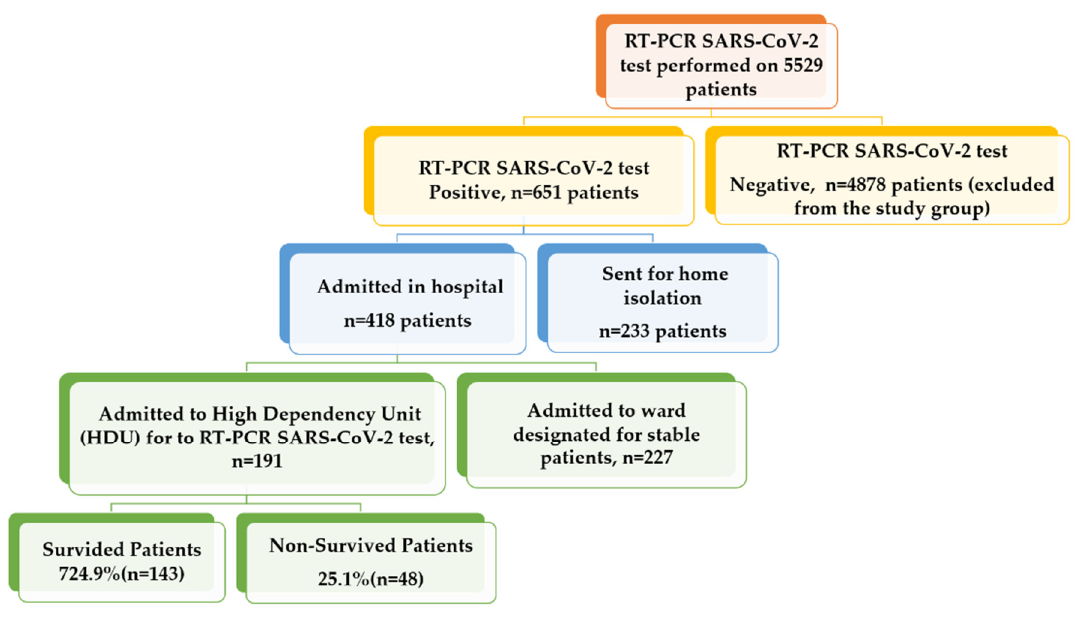
Figure 1. The flowchart showing the distribution of COVID-19 patients among different sections in sequential